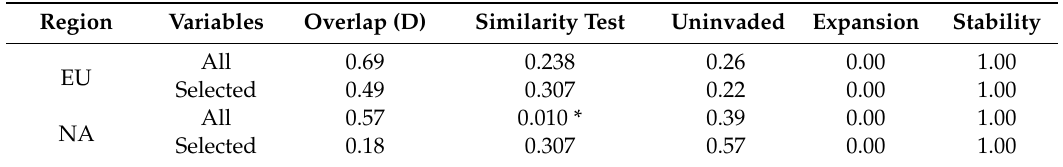
Table A4. Summary of p values for the niche test of Dutch elm disease between invasive ranges Europe (EU) and North America (NA) and native range Asia using all and selected climatic variables (2 → 1). Significant p values ( α = 0.05) are represented by